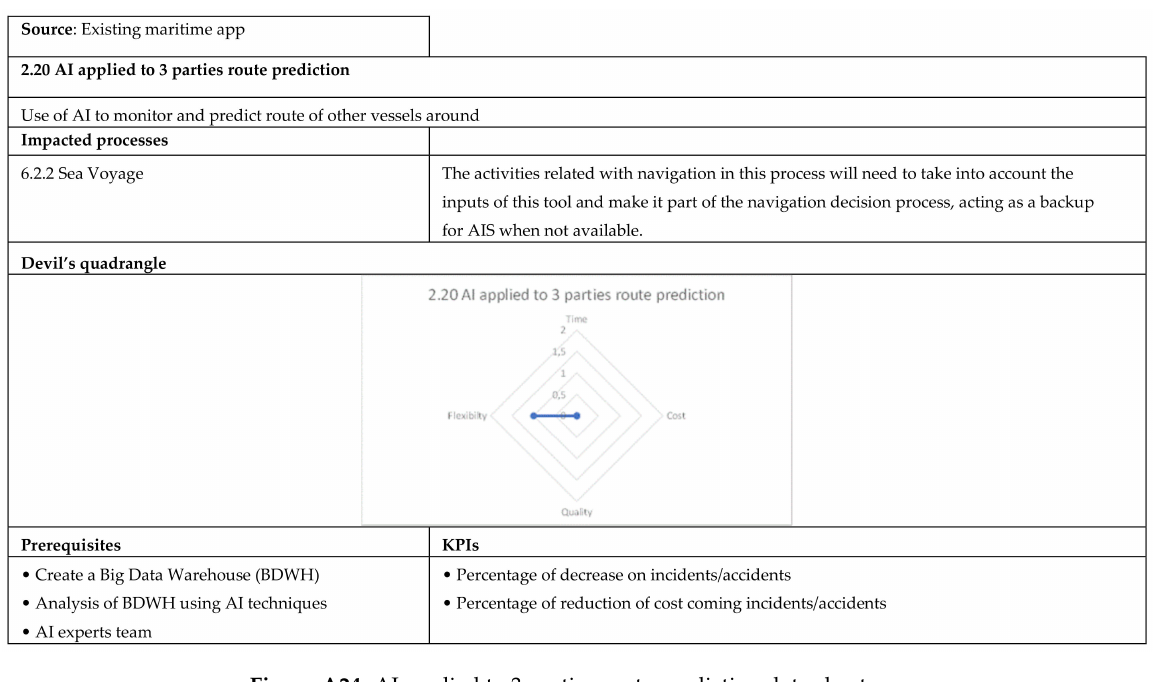
Figure A24. AI applied to 3 parties route prediction data sheet.